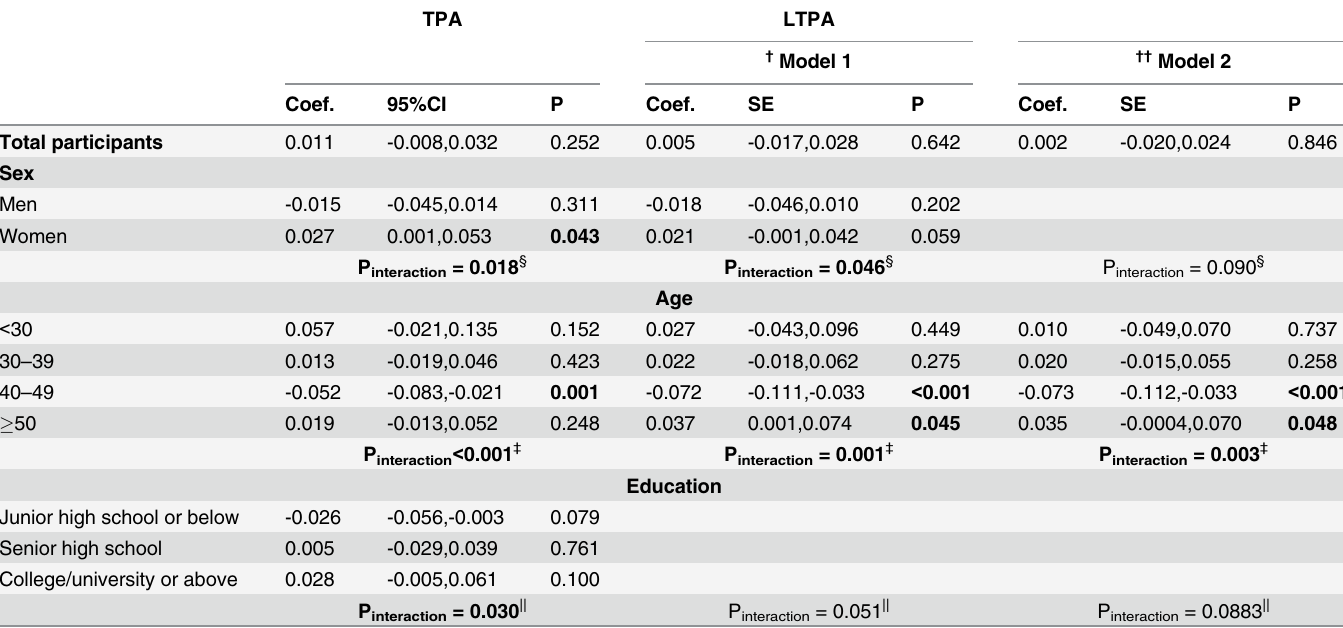
Table 3. Multilevel regressions between BMI and TPA/LTPA stratified by socio-demographic category.